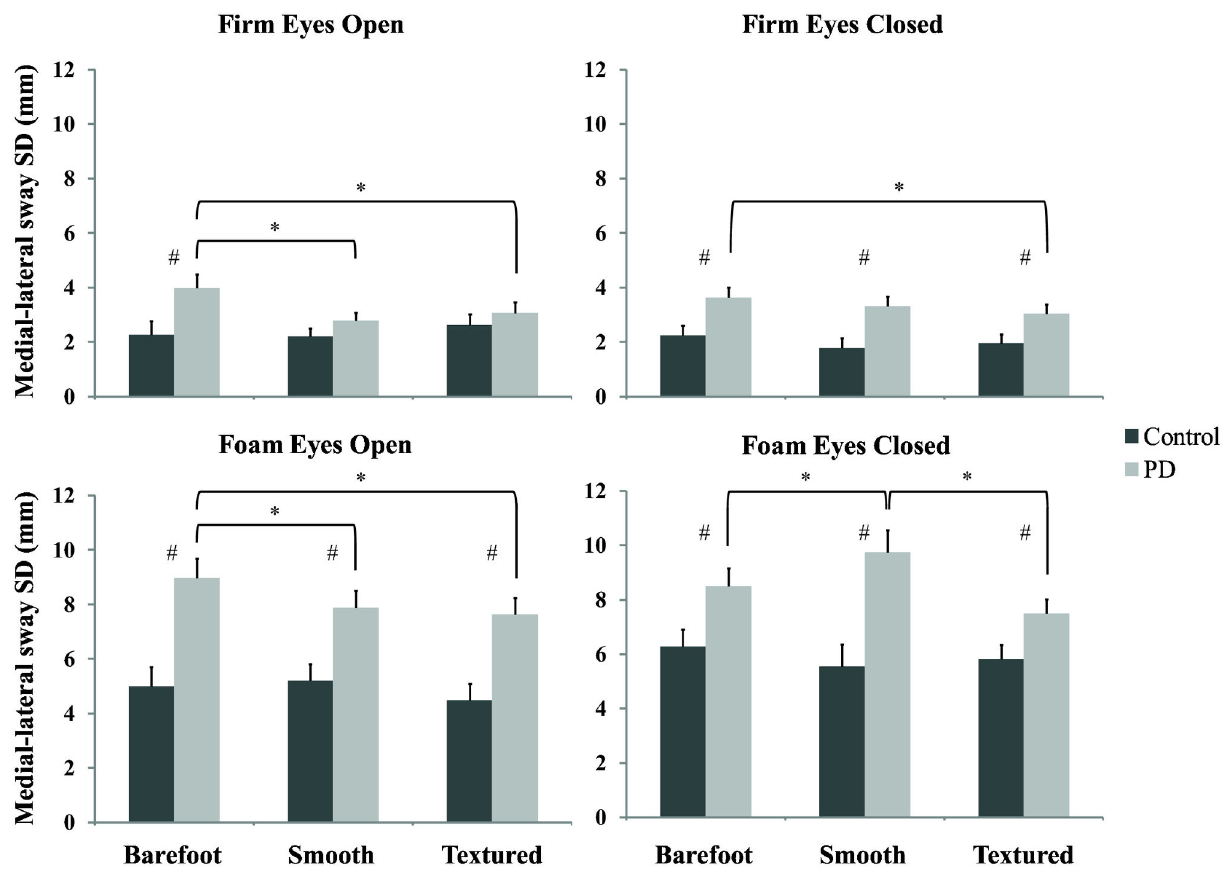
Figure 3. Mean (+1 SD) medial-lateral sway standard deviation for the control (black) and PD (grey) participants during the four standing conditions. Note: # denotes a significant difference between the PD and control groups; * denotes a significant difference between the footwear conditions for the PD